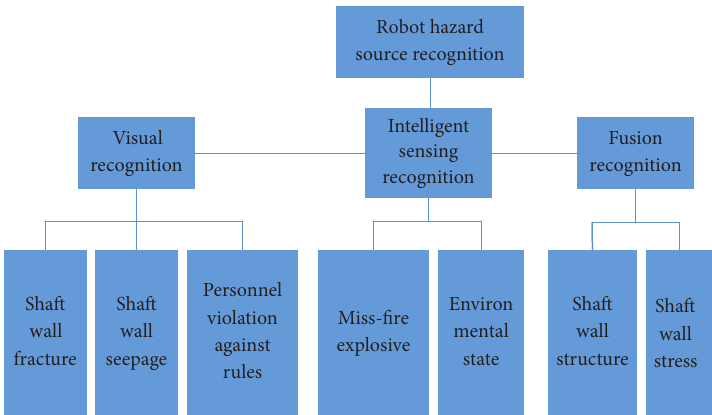
Figure 13: Functions of hazard source recognition module.